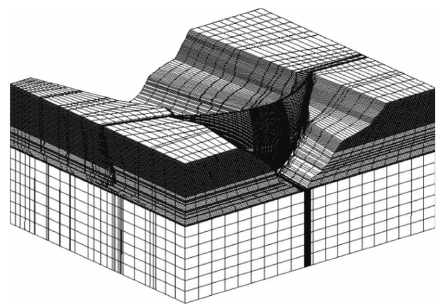
Figure 10: Numerical model of Xiaowan arch dam.